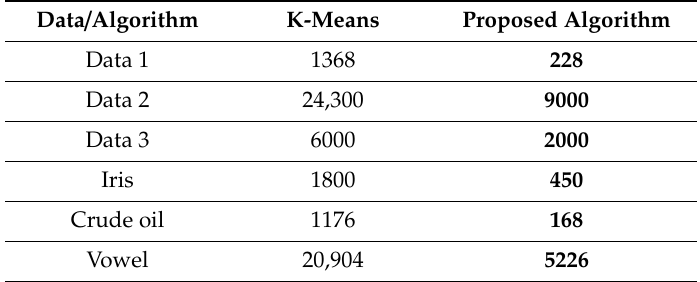
Table 3. Number of nearest neighbor (ngh) queries in the algorithms for the used datasets. Data / Algorithm K-Means Proposed Algorithm Data 1